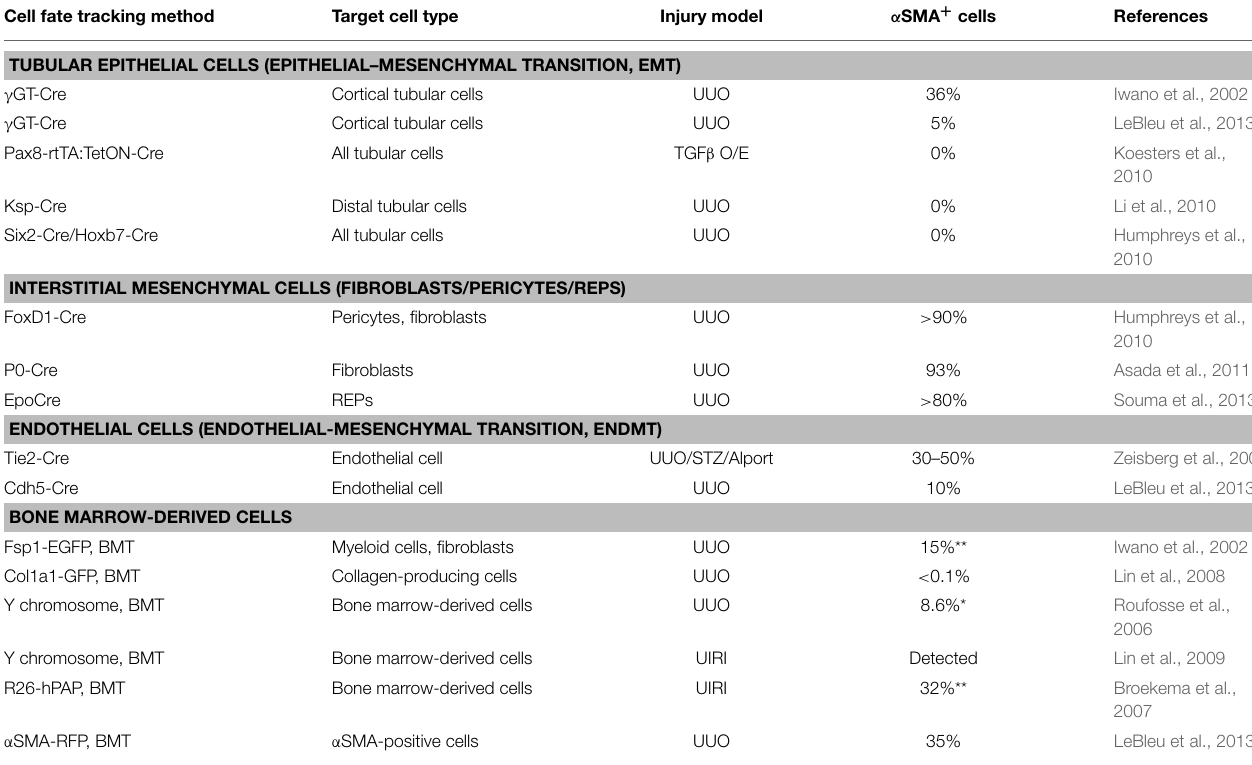
TABLE 2 | Summary of the origins of renal